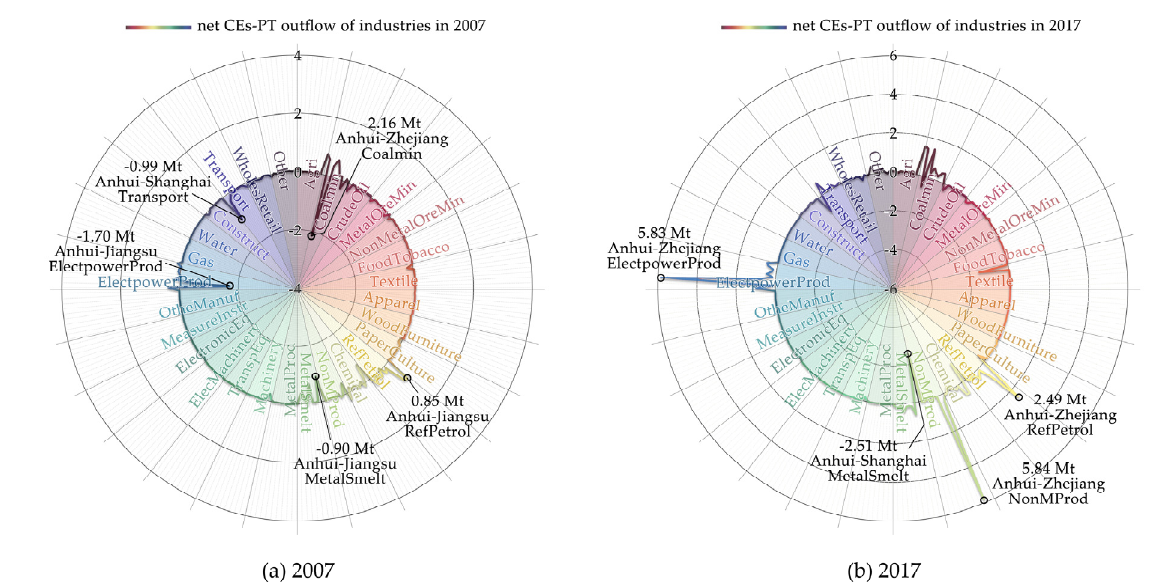
Figure 7. Net ECEs-IPT outflow of industry sectors in Anhui among the YREB from 2007 ( a ) to 2017 ( b ).